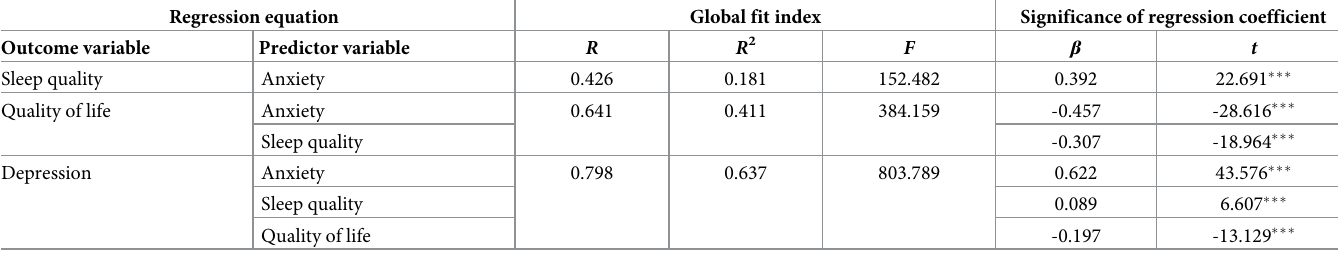
Table 3. Regression analysis between variables.